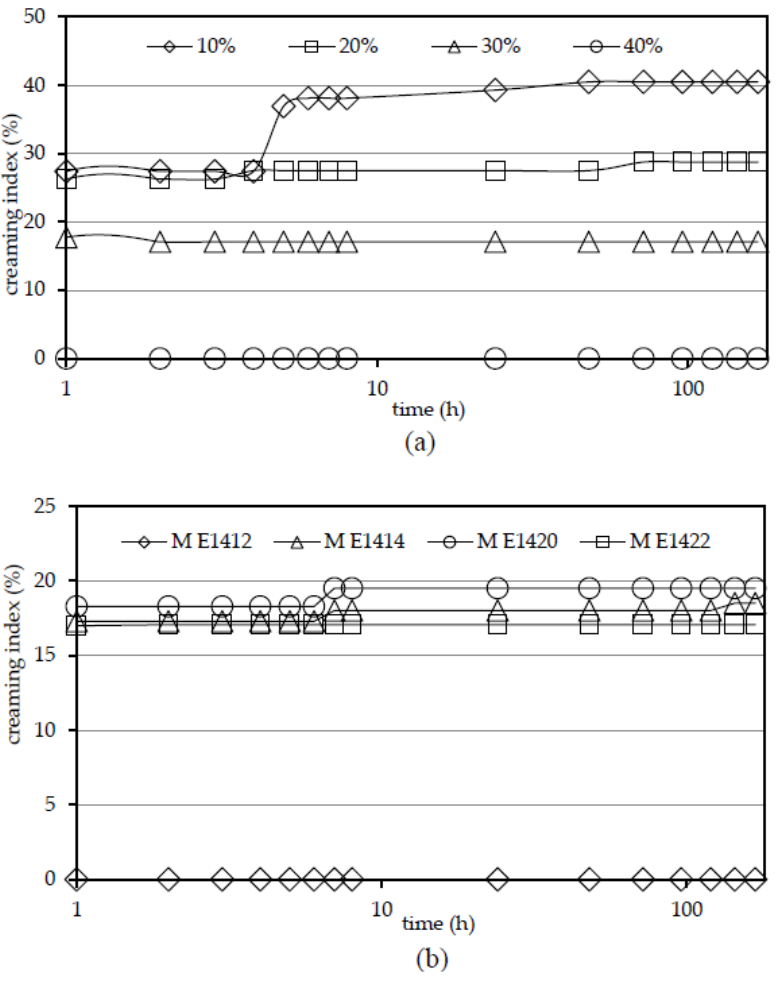
Figure 1. Creaming index of o/w emulsions with different concentration of M E1422 (DE 6) addition ( a ); and with addition different maltodextrins (DE 6) at 30% concentration ( b ).